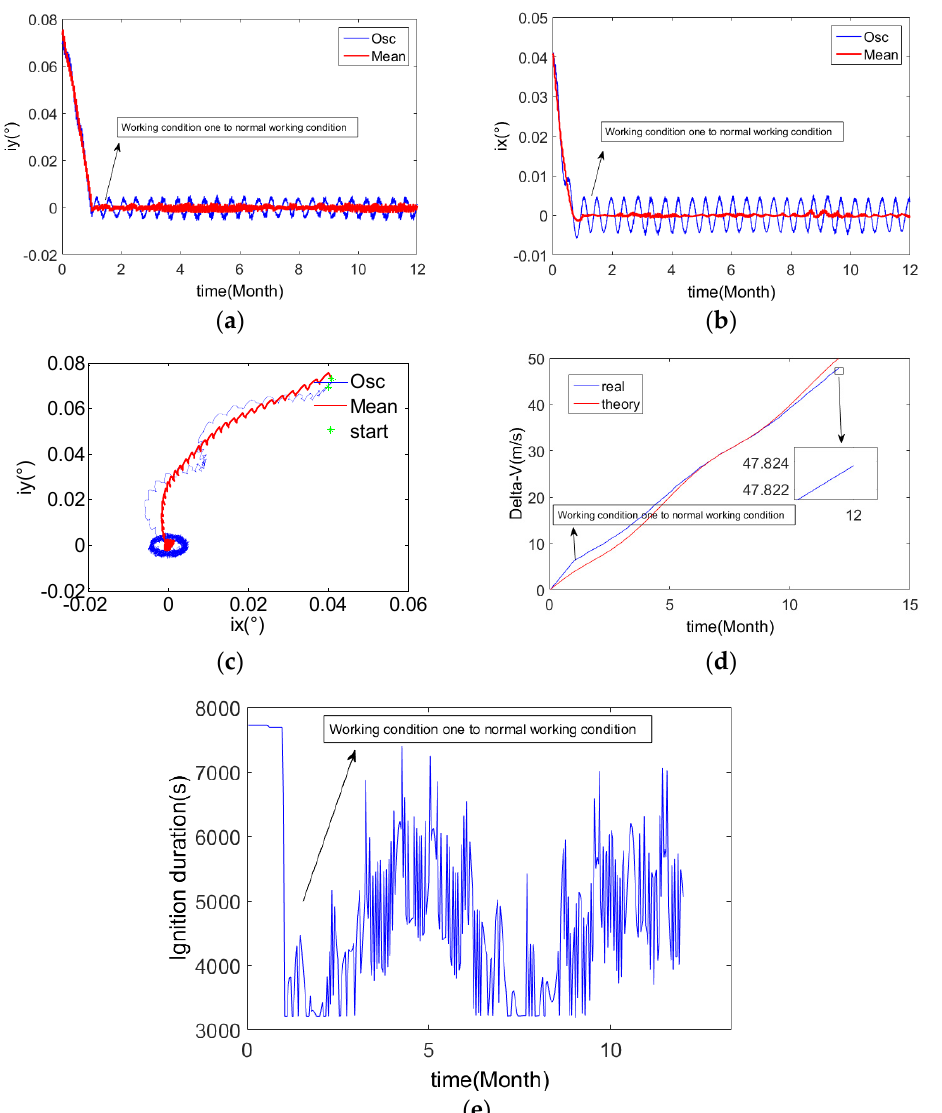
Figure 17. The results of the example four. ( a ) Y-axis component of orbital inclination vector; ( b ) X-axis component of orbital inclination vector; ( c ) Orbital inclination vector; ( d ) Velocity increment for SK; ( e ) Duration of SK.